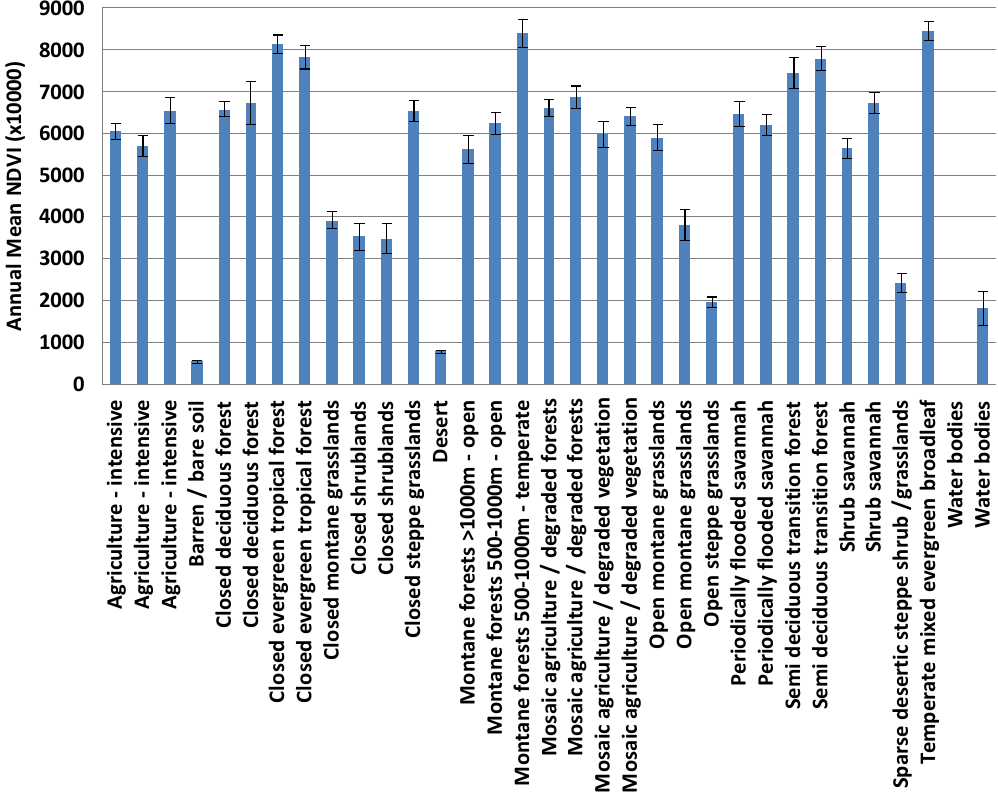
Figure 5. The low mean NDVI values or low productivity areas are diagonally situated across the Andes Mountains. Strong increasing productivity gradients are observed from the desert coast across the Andes mountains into tropical forests in the northern latitudes (North of −32°S latitude), while we observe the opposite pattern in productivity in the more temperate southern latitudes (~−32°S latitude), temperate forest on the coast and shrubland across the Andes mountains to the east. Tropical and temperate forested areas show the regions with the highest productivity, followed by agriculturally intensive areas. Many of the patterns seen in the mean NDVI in Figure 5 follow along well established precipitation and temperature gradients classified by the recently updated Köppen-Geiger system map [59]. Most of the higher interannual variability represented by higher COV of the annual NDVI values are associated with areas on and along the Andes Mountains, complemented by some of the shrubland regions in the central-northern parts of Chile and southwestern parts of Argentina. These shrubland regions are often drought deciduous/tolerant and will have strong leaf-out and growth of herbaceous plants in response to